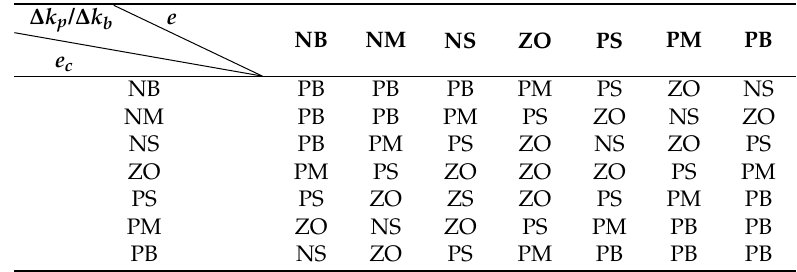
Table 1. Fuzzy control of ∆ k d